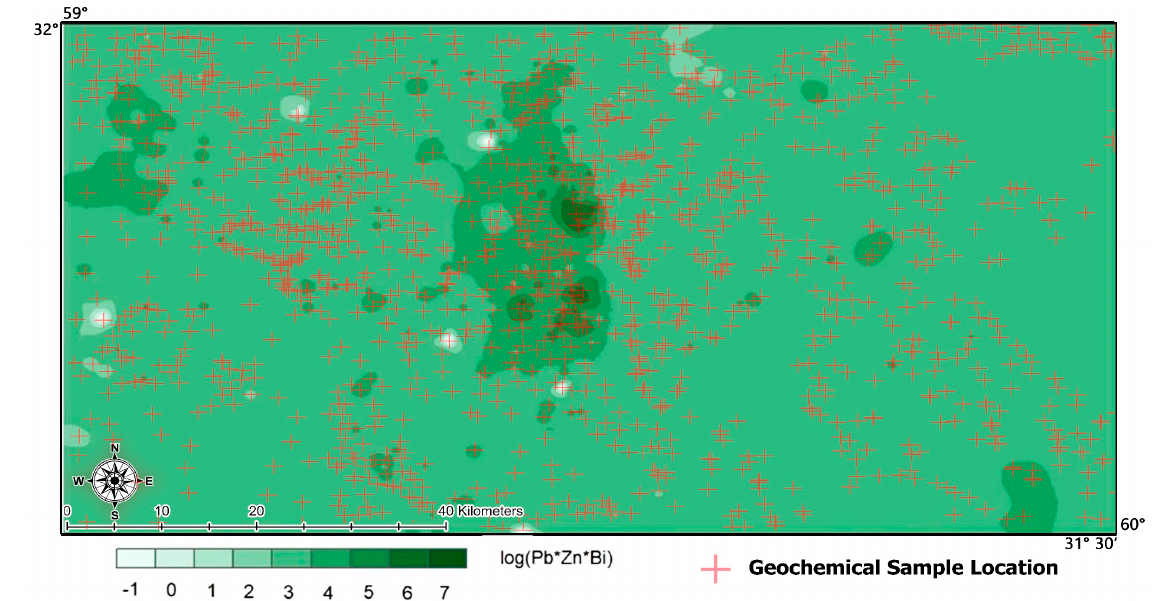
Figure 13. The map of supra-mineral elements distribution based on stream sediment samples (us- ing the IDW interpolation method).